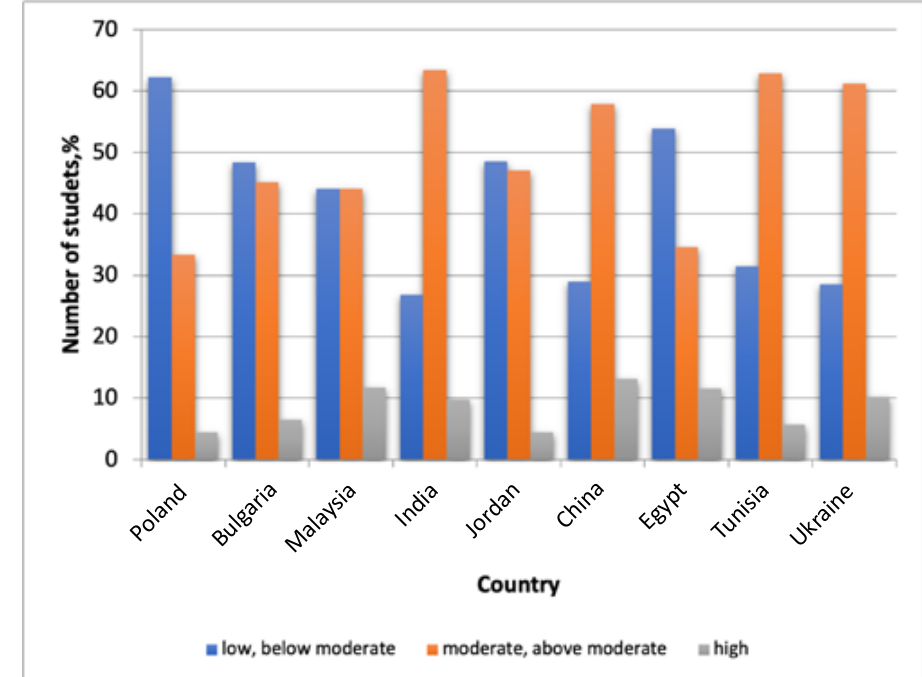
Figure 3. Distribution of students by Vital capacity index level (units)